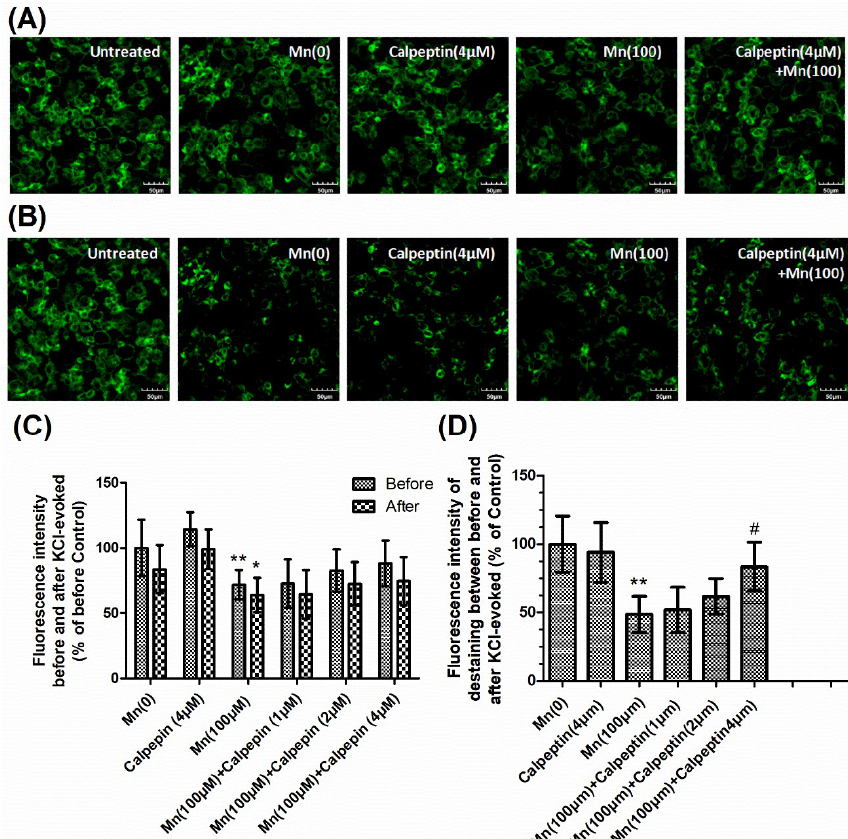
Figure 4. Calpeptin promoted KCl-evoked synaptic vesicle fusion. After treatment with different doses of Mn, cells were incubated with 100 µ M FM1-43 for 2 min in HEPES buffer medium (HBM) containing 1 mM Ca 2+ and 30 mM K + . ( A ) The FM1-43 fluorescence before KCl-evoked exocytosis. ( B ) The FM1-43 fluorescence 30 min after 15 mM KCl-evoked exocytosis. Untreated sample represented the normal downloading of the fluorescent dye in neurons neither KCl-evoked nor Mn-treated. ( C ) Fluorescence intensity before and after KCl-evoked exocytosis in different groups normalized with those of controls. ( D ) Relative fluorescence intensity between ( A ) and ( B ) in different groups normalized with those of controls. Data represent mean ± standard deviation, n = 4. * p < 0.05 and ** p < 0.01 indicates significant differences from controls; # p < 0.05 indicates significant differences from the 100 µ M Mn-treated group. Scale bars: 50 µ